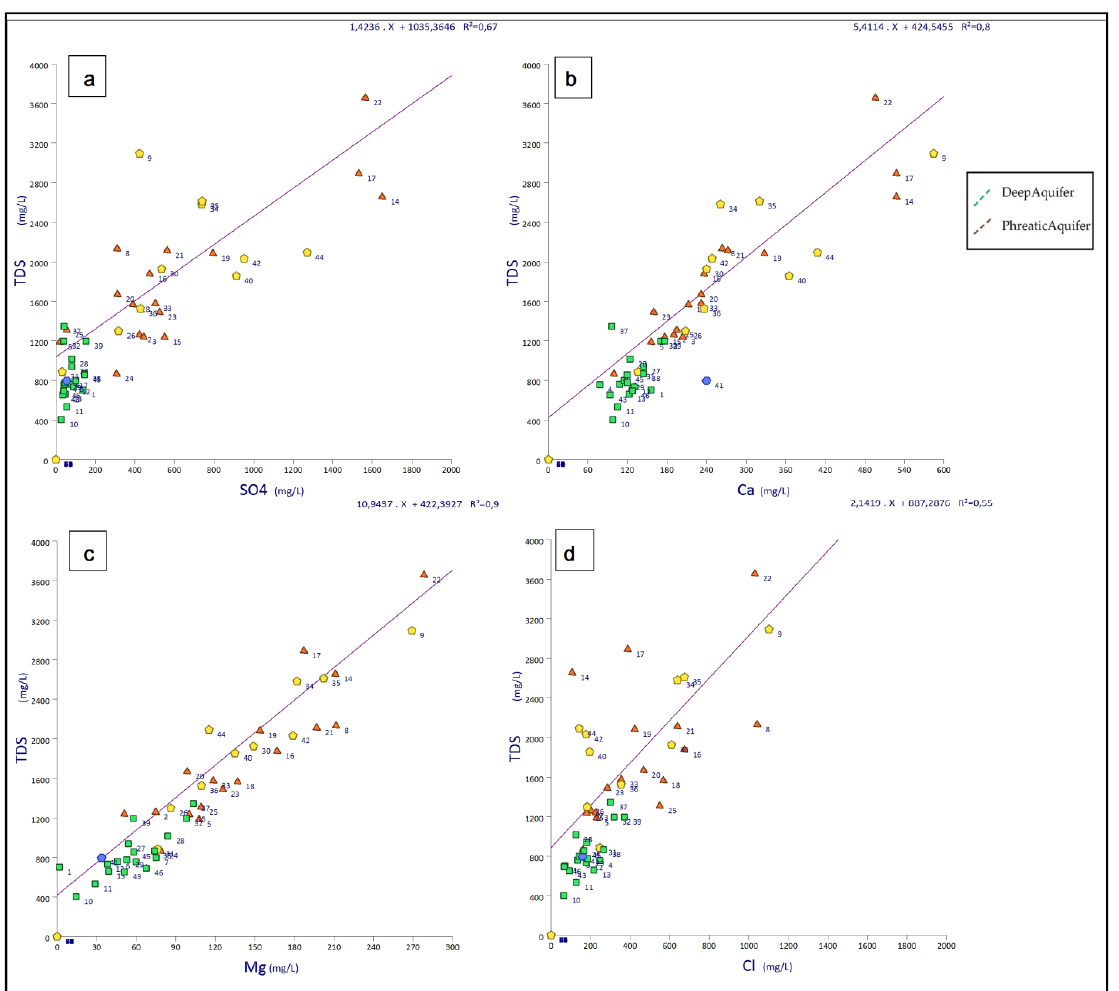
Figure 9. Relationships between the dissolved major ions versus the total dissolved solids for all the samples. ( a ) SO 4 , ( b ) Ca, ( c ) Mg, ( d ) Cl.